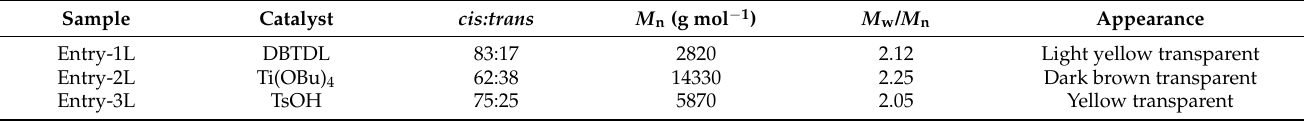
Table 2. Effect of catalyst type on the polymerization and properties of